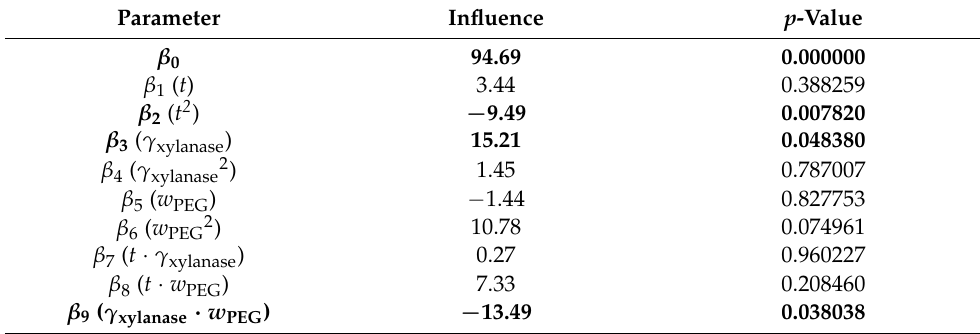
Table 4. RSM model for description of xylanase extraction